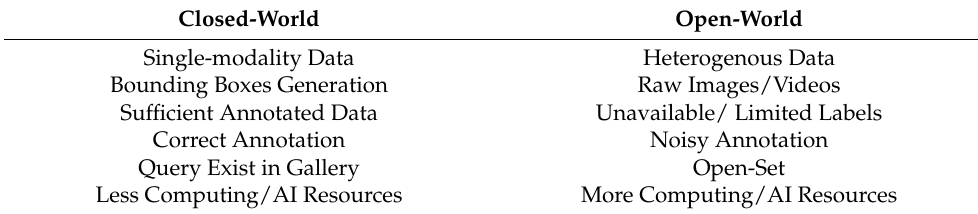
Table 1. Closed-world versus open-world person